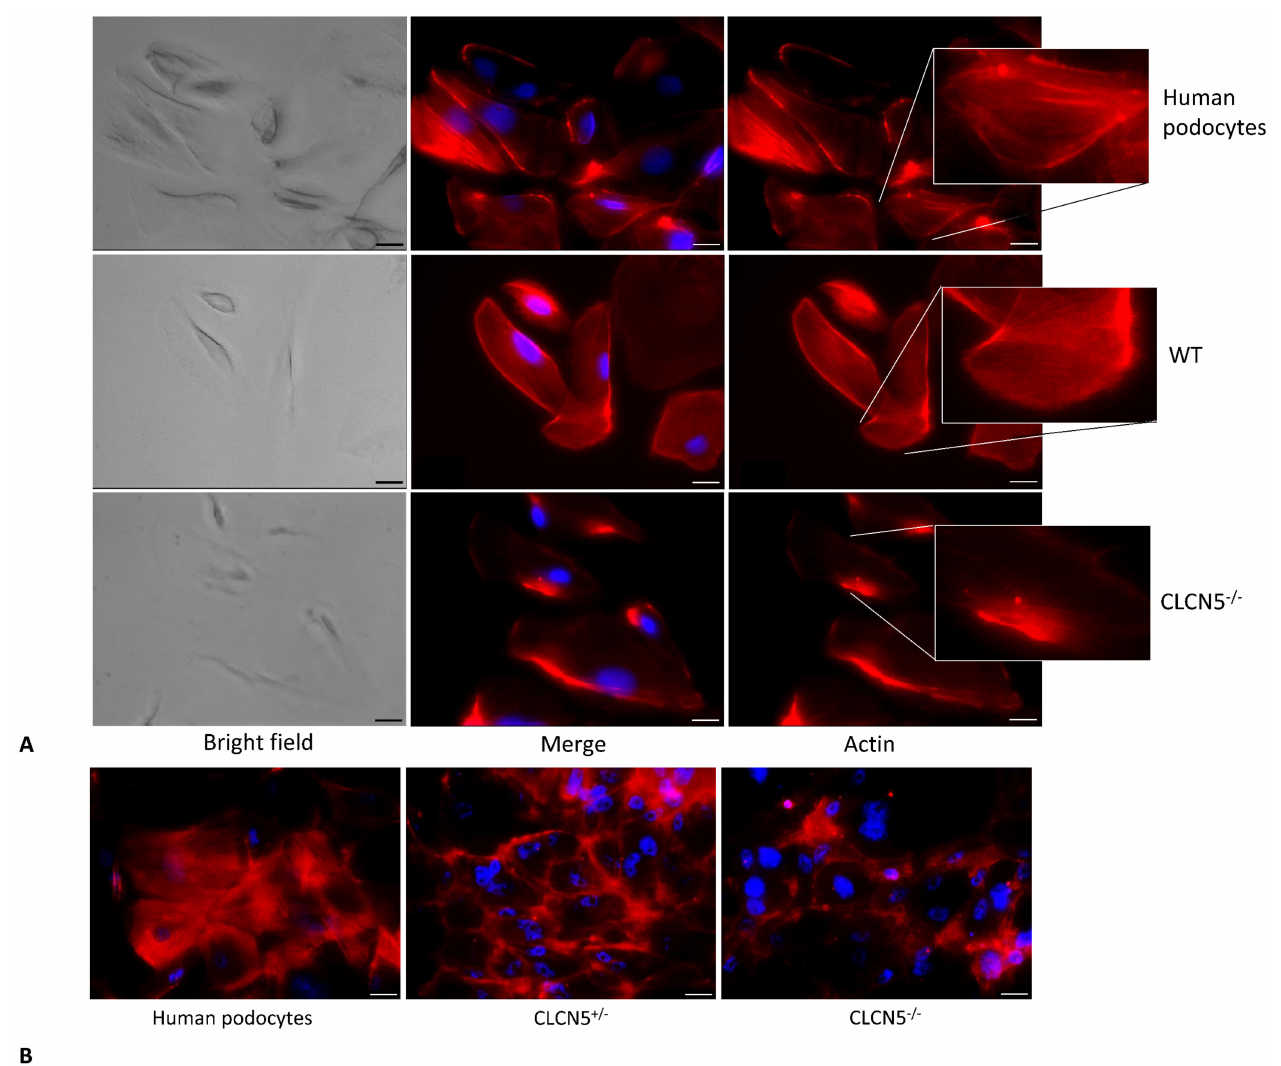
Figure 6. Phalloidin fluorescence labelling of F-actin of human podocytes, WT, and CLCN5 − / − clones. Representative images (with boxed photos showing zoomed-in area) demonstrating: ( A ) no difference in the staining pattern between human podocytes and WT clones, while irregular F-actin distribution in CLCN5 − / − clones was markedly present; ( B ) differences in the staining pattern be- tween heterozygous ( CLCN5 +/ − ) and homozygous ( CLCN5 − / − ) clones: actin cytoskeleton alteration of heterozygous clones was intermediate between normal human podocytes and homozygous clones. Red: actin; Blue: DAPI. Images were acquired using a DMI6000CS-TCS SP8 fluorescence microscope (Leica Microystems, Wetzlar, Germany) with 20 × /0.4 objective. Fluorescence microscope images